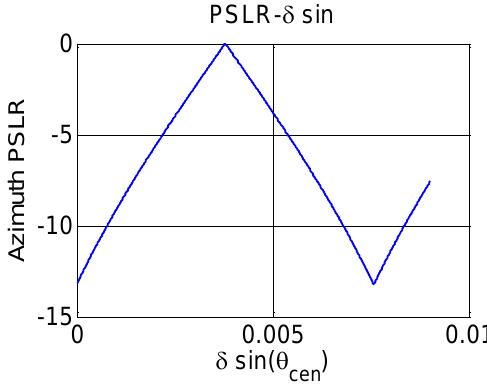
Figure 11. Relationship between PSLR and offset.